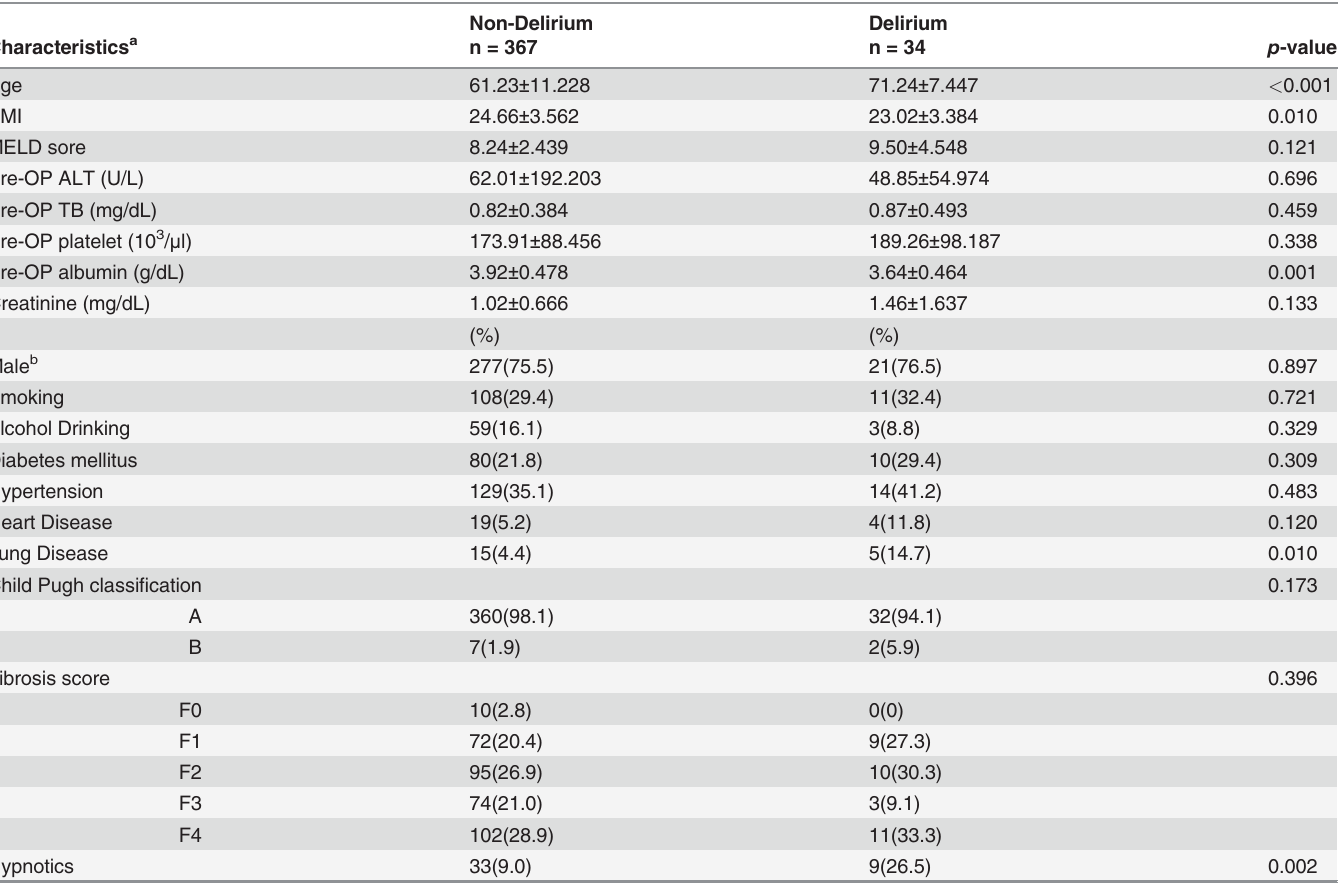
Table 2. Characteristics of patients in the delirium and non-delirium